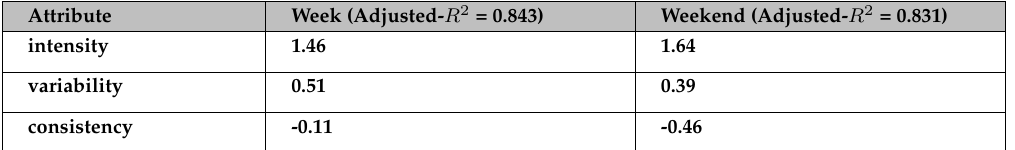
Table 3: Regression results: coefficients (weights) and Adjusted- R 2